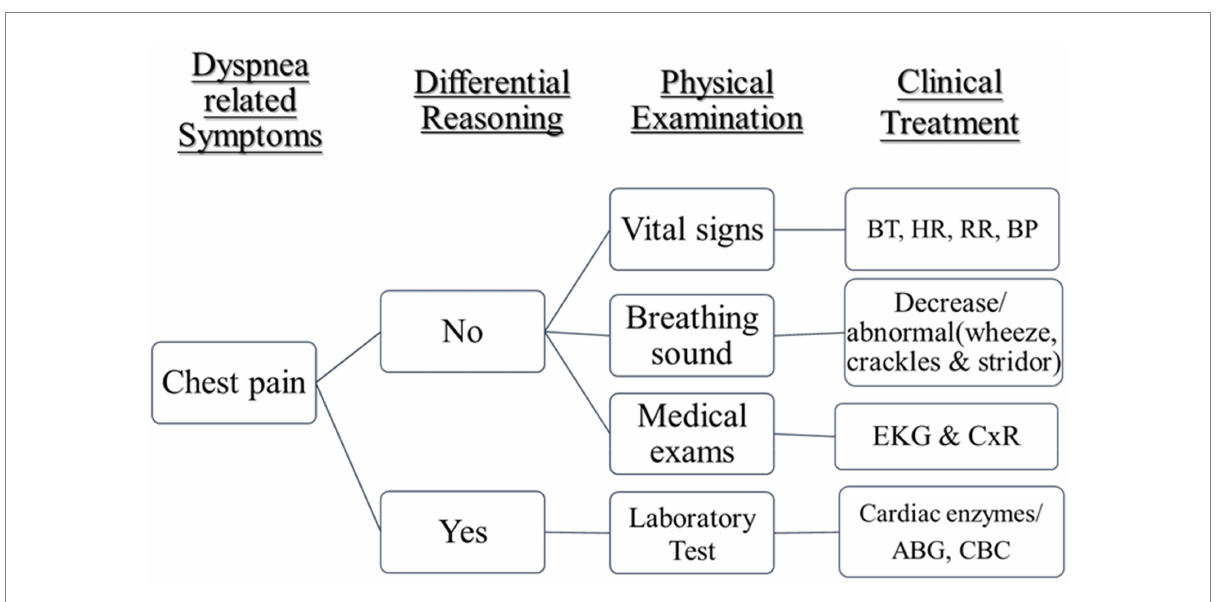
FIGURE 2 Dyspnea clinical treatment flowchart (Parshall et al.,